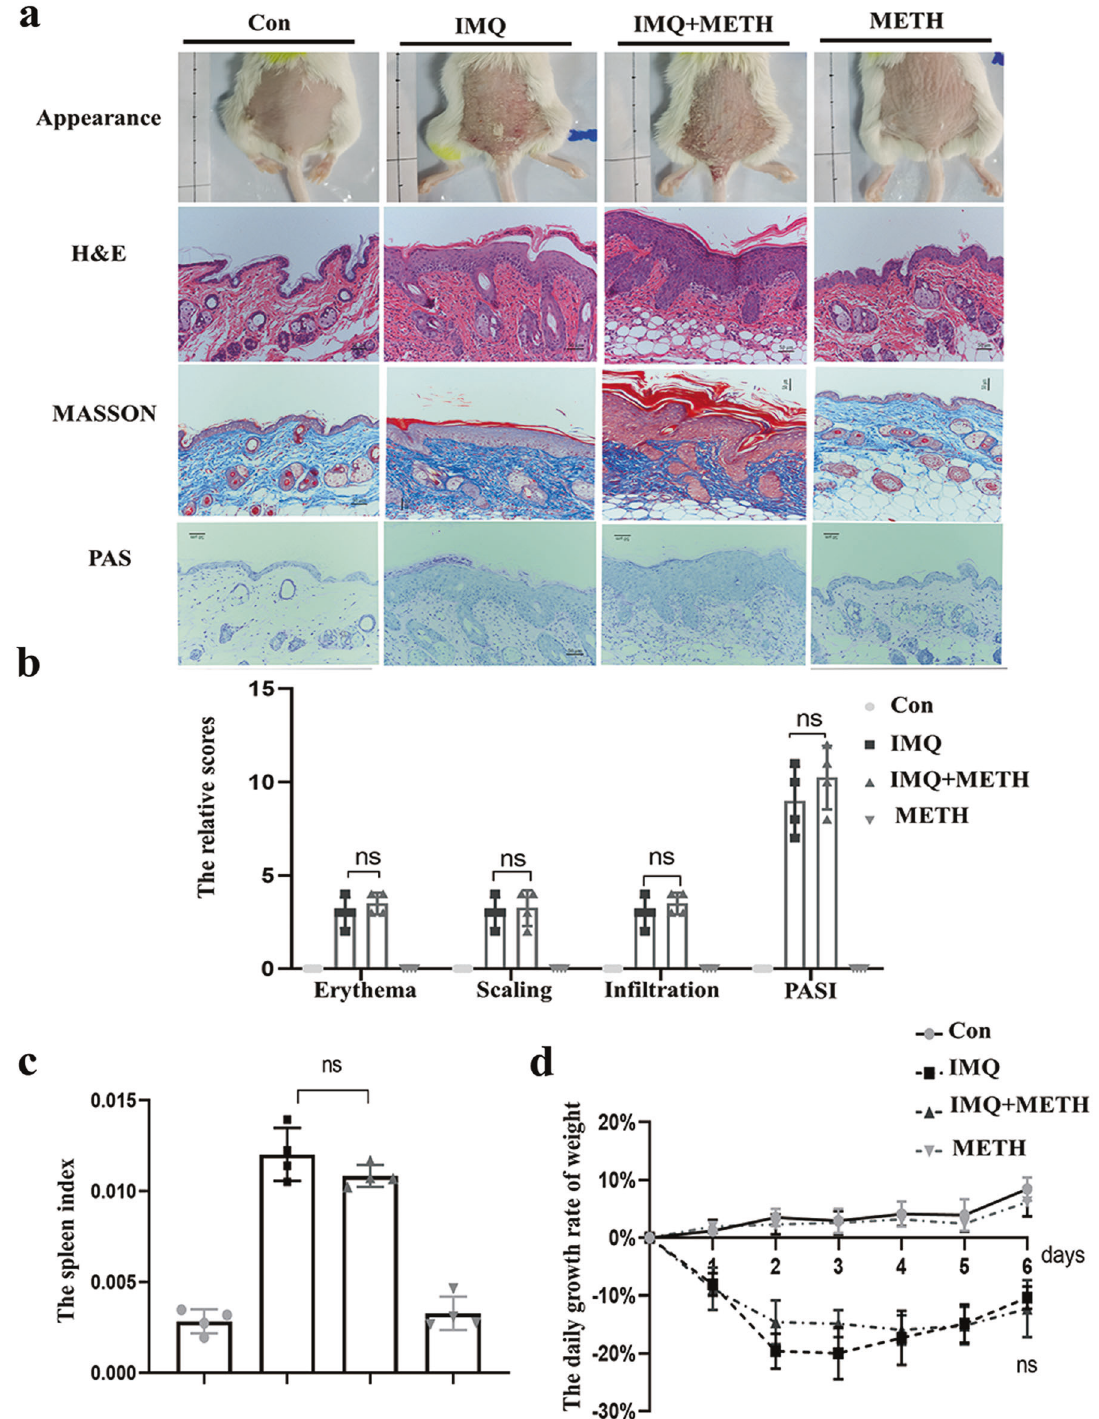
Fig. 7 α 7nAChR antagonist treatment exacerbates the abnormal epidermal proliferation and differentiation in psoriatic mice model. a The application of α 7nAChR antagonist Methyllycaconitine citrate led to mildly aggravated psoriasis. H&E staining and epidermal thickness measurements were analyzed in a different group (magni fi cation ×200). b Erythema, scaling, in fi ltration, and PASI score indicated IMQ + METH group had slight worsen symptoms than the IMQ group, but there was no statistical difference. c Spleen change to weight ratio was calculated to analysis the in fl ammatory state in mice. d Mice in IMQ + METH group had the similar daily growth rate of weight to IMQ-induced model group. Data are presented as mean ± SD, n = 6.